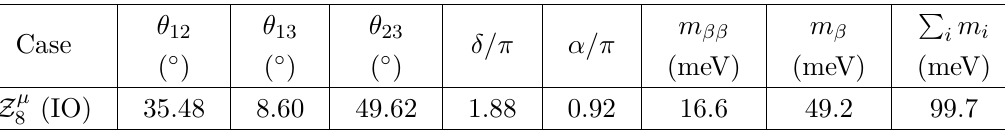
Table 3 . θ 12 , θ 13 , θ 23 , δ , α , m ββ , m β and P m i best-fit values for the only case compatible with i neutrino oscillation data at the 1 σ level: Z µ muon-decoupled with IO neutrino masses. All the 8 remaining cases, Z e , Z τ and Z µ for NO, and considering all possible decoupled charged-lepton 8 8 8 states, are not compatible with data.